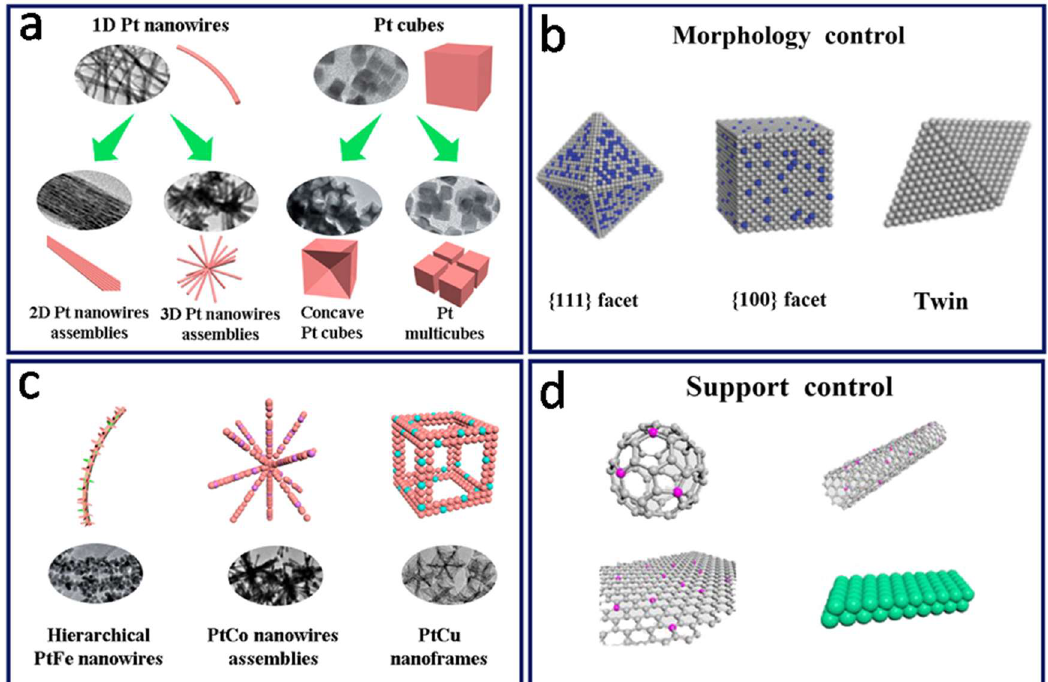
Figure 3. ( a ) Structure control of Pt-based catalysts. ( b ) Morphology control of Pt-based catalysts. ( c ) Composition control of Pt-based catalysts. ( d ) Optimization of Pt-based catalyst supports. Reproduced from ref. [26] and ref. [87] with permission from Wiley-VCH (copyright 2019) and American Chemical Society (copyright 2021), respectively.